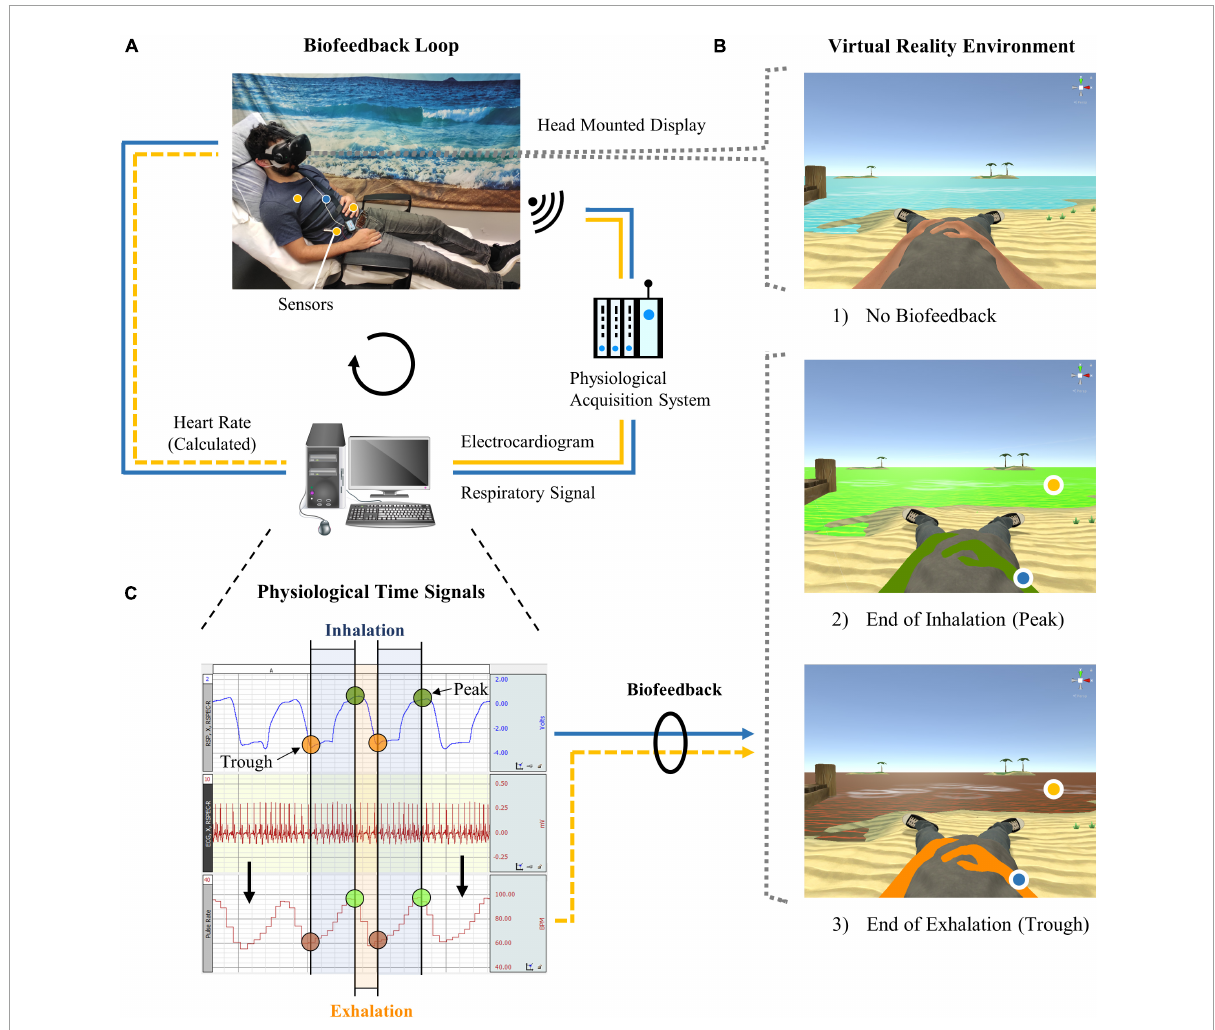
FIGURE1 Virtual reality biofeedback system. (A) During heart rate variability biofeedback training, which involved slow and rhythmic breathing, abdominal and thoracic circumference as well as an electrocardiogram were recorded through a respiration belt and surface electrodes (hidden under the shirt). Signals were processed by a computer and could be visualized in the virtual reality environment. (B) Participants in (1) the active control group followed the same training but received no biofeedback. Biofeedback was displayed by colors of the avatar (respiration) and sea (heart rate) that changed gradually from (2) green to (3) orange/red during exhalation or when the heart rate dropped, respectively, and vice versa. (C) The target of the training was, as exemplified here, to maintain synchrony between the respiration and heart rate time signals (i.e., similar color between the avatar and sea) and to increase the heart rate amplitude (i.e., stronger shades of green and red for the